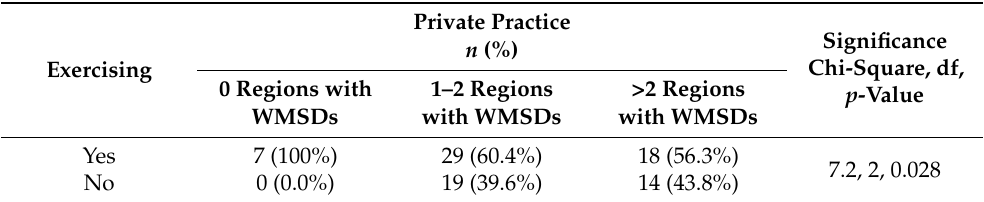
Table 4. A comparison of physical activities and the number of regions affected with WMSDs among dentists in private practices.